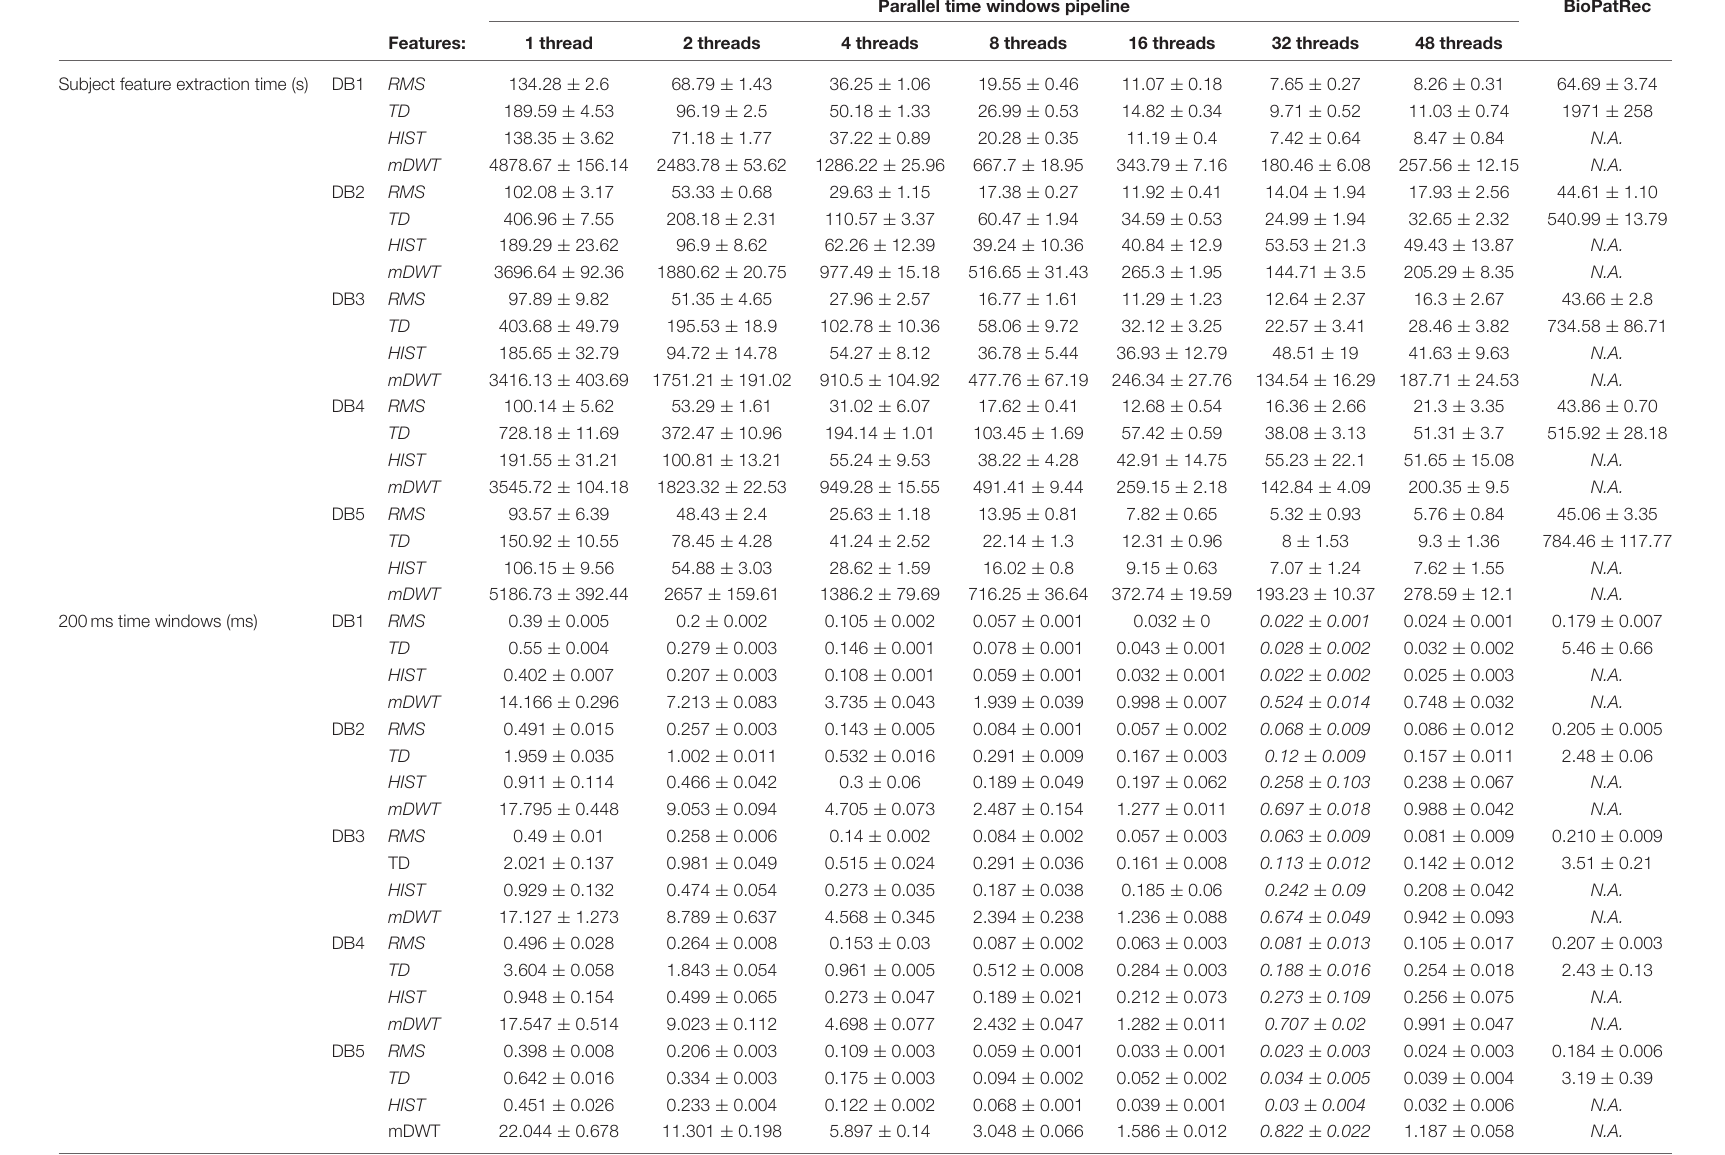
TABLE 1 | Feature extraction times for different datasets and